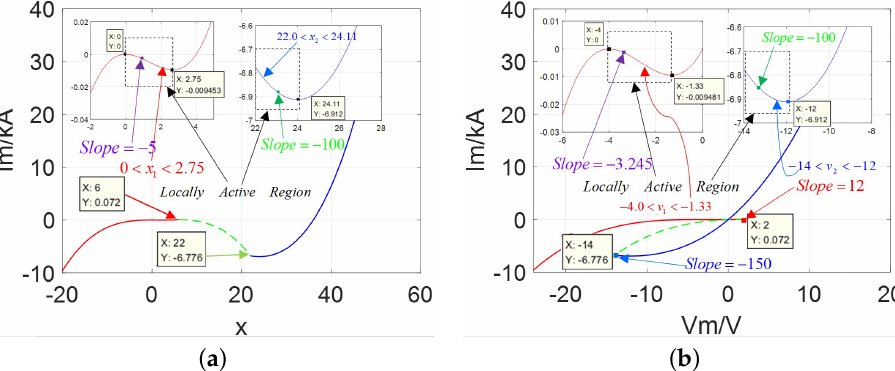
Figure 7. Loci of Ivs . X and DC V − I curves: ( a ) Ivs . X with only one negative slope domain in the